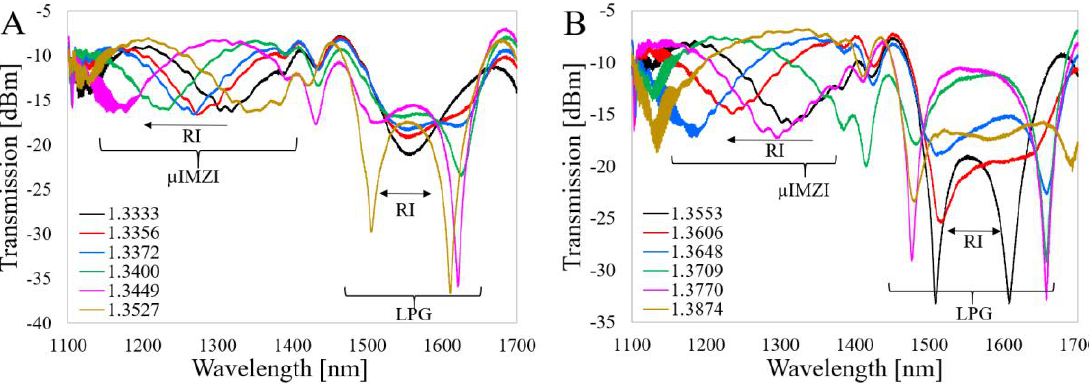
Figure 5. Spectral response of the LPG-µIMZI structure to RI in ranges: ( a ) from 1.3333 to 1.3527 RIU and ( b ) from 1.3553 to 1.3874 RIU. The effects corresponding to the LPG and µIMZI are marked in the figures.